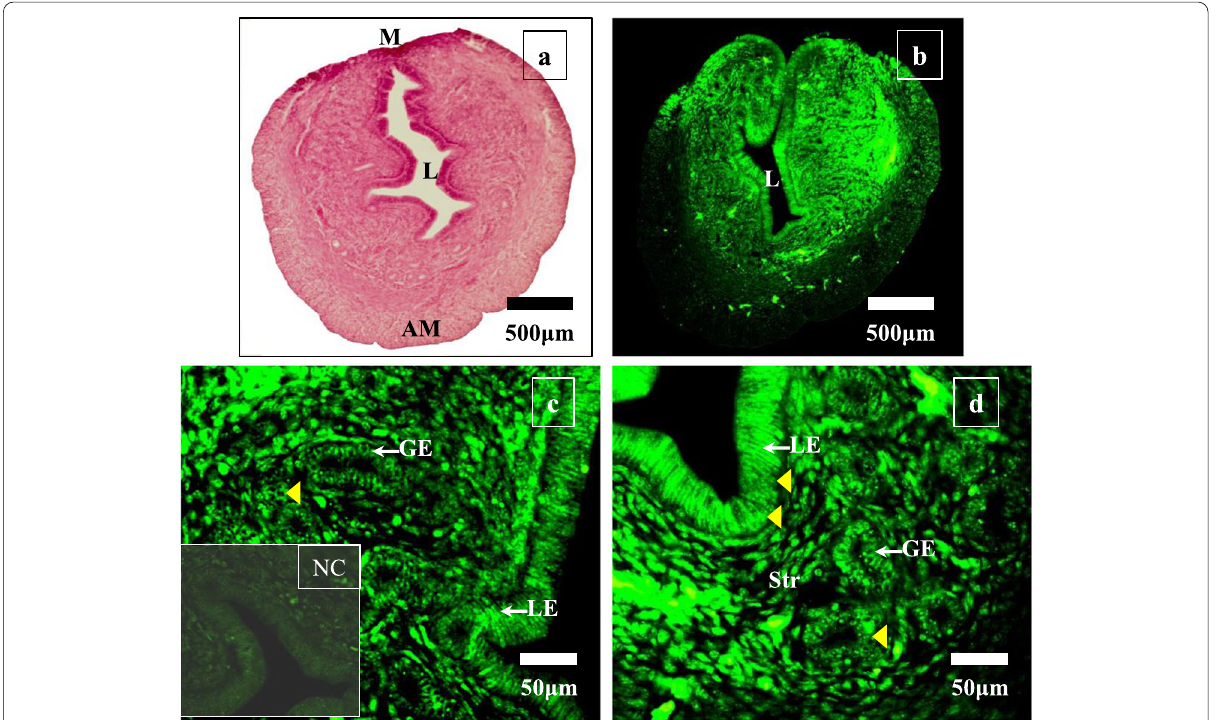
Fig. 9 Immunofluorescence of KLF5 on AntiP4-treated D4 mice uterus using FITC-conjugated antibody. The protein was localized in the luminal epithelium (LE) and glandular epithelium (GE) of uterine glands and stroma (Str). The arrowhead indicates the expression. Original magnification: a 5 , b 5 , c 40 , d 40 . L, lumen; M, mesometrial pole; AM, antimesometrial pole; NC, negative × × × ×